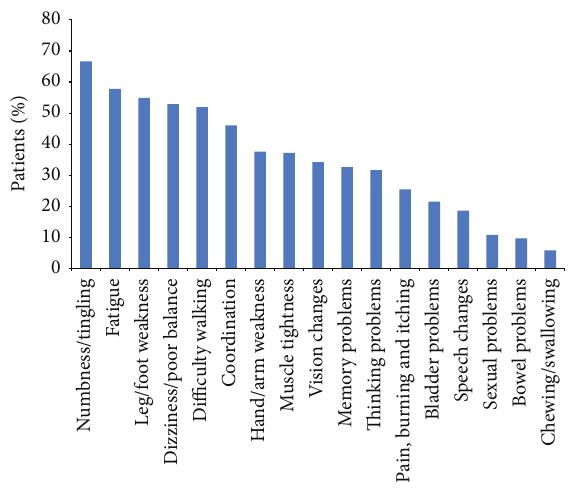
Figure 1: New or worsening symptoms of current (new) relapse. ARMS: Assessing Relapse in Multiple Sclerosis.